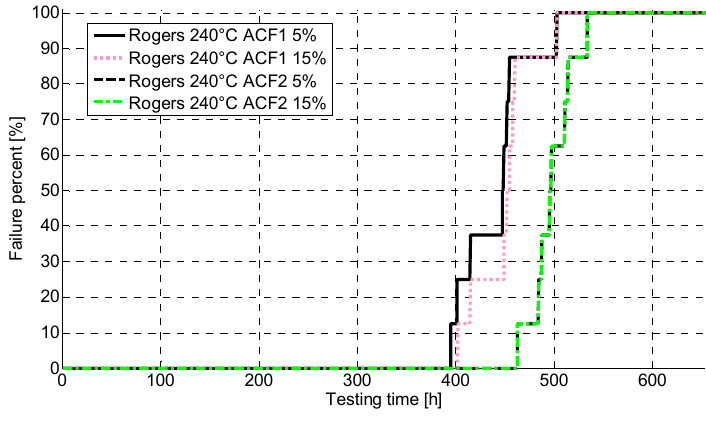
Figure 8. CDF for Rogers PCB at 240 °C.